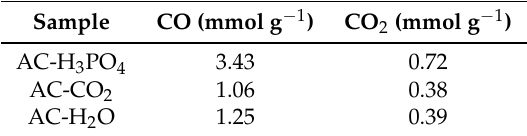
Table 2. Cumulated amounts of the emitted CO and CO 2 during the temperature programmed desorption (TPD-MS) analysis of carbon